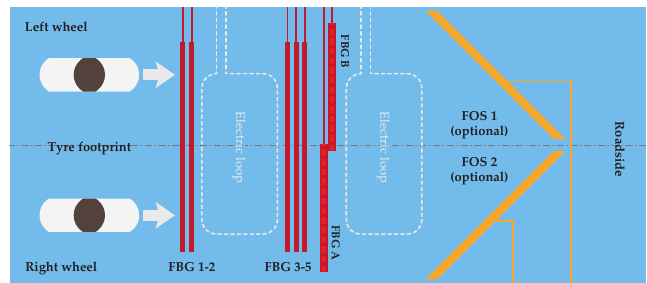
Figure 16. Proposed experimental platform with Fiber Optic Sensors (FOS) with 45 ◦ orientations (orange